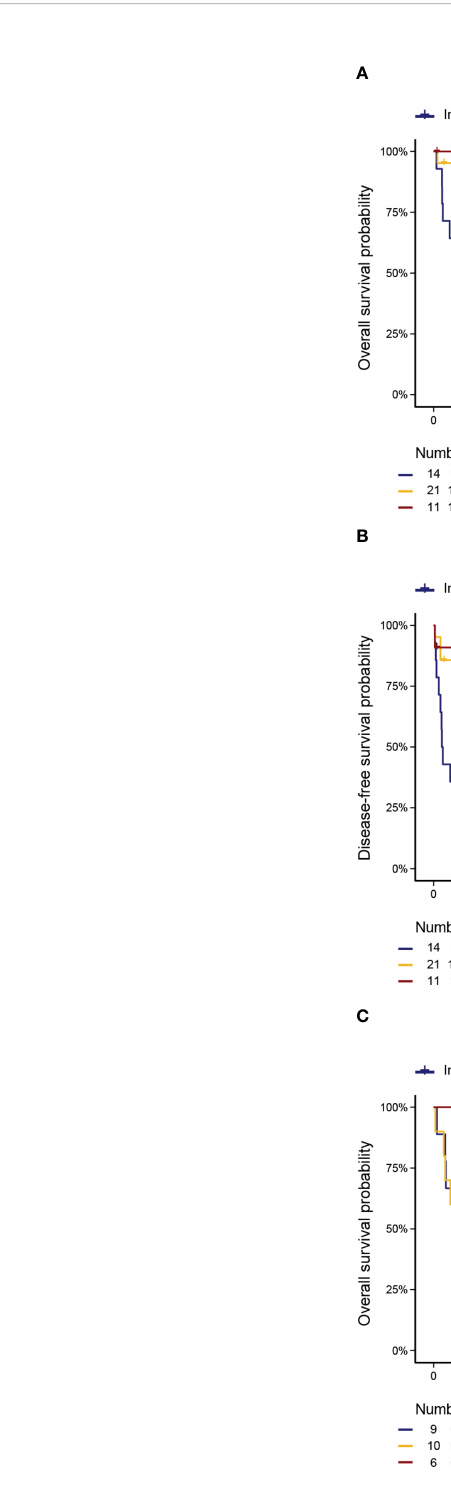
FIGURE 4 Immune Clusters are associated with Overall Survival and Disease-Free Survival in Primary UPS. Kaplan Meier curves of (A) overall survival and (B) disease-free survival in primary UPS, and (C) overall survival in recurrent UPS. P-values are log-rank test for comparison of survival